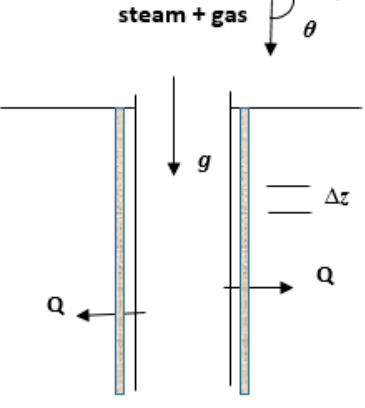
Figure. 1. Schematic diagram of 1D flow. Figure 1. Schematic diagram of 1D